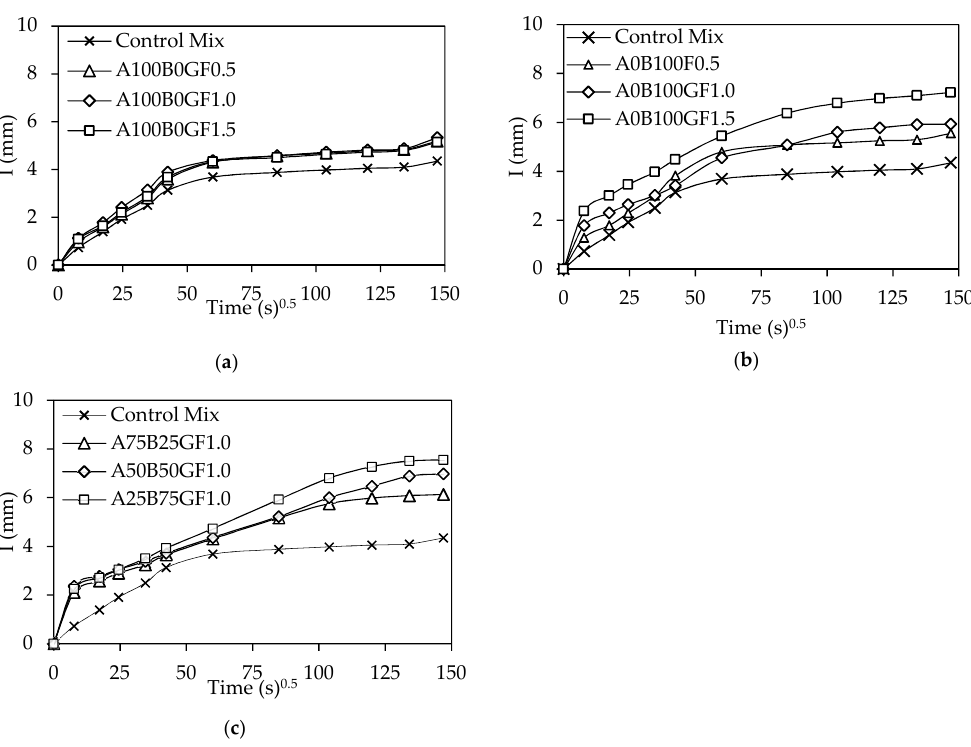
Figure 13. Absorption of geopolymer concrete mixes over time: ( a ) Series A, ( b ) Series B, and ( c ) Series C.